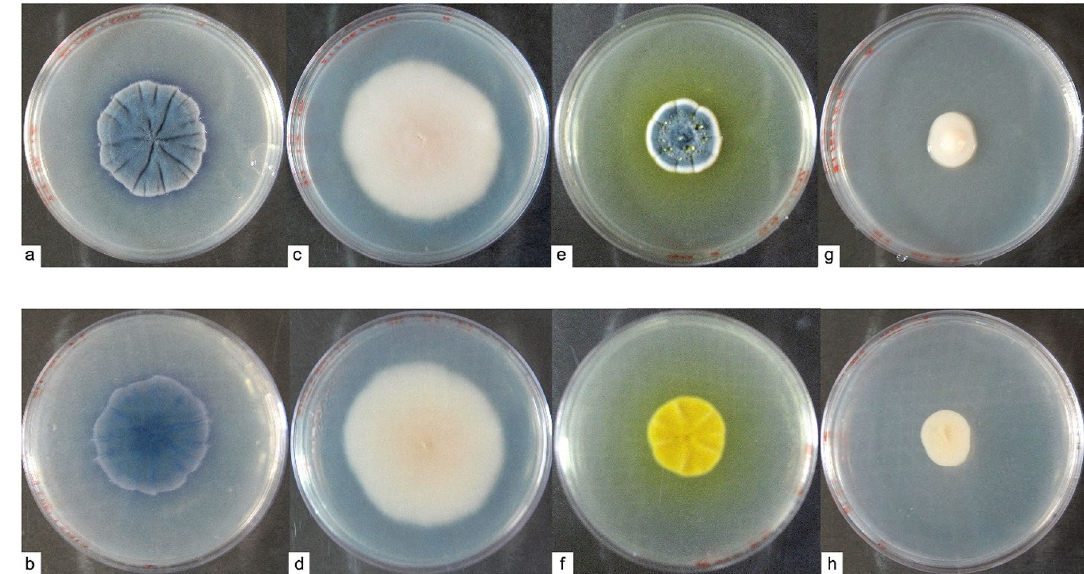
Figure 2. Macroscopic observation of Antarctic fungi isolates. Colonies were grown on PDA for 30 days at 4 °C. Upper panel: front of the colony. Lower panel: reverse of the colony. ( a , b ) Antarctomyces sp.; ( c , d ) Thelebolus sp.; ( e , f ) Penicillium sp.; ( g , h ) Cryptococcus gilvescens .